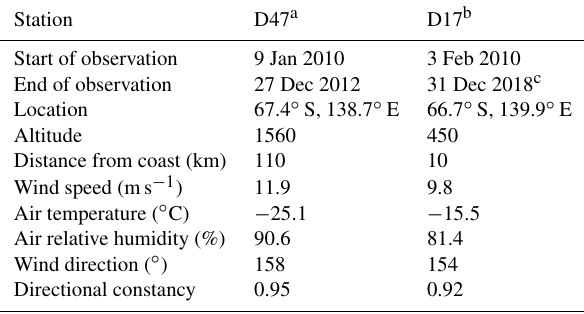
Table 1. Geographical and climate characteristics of the two mea- surement locations for the respective observation